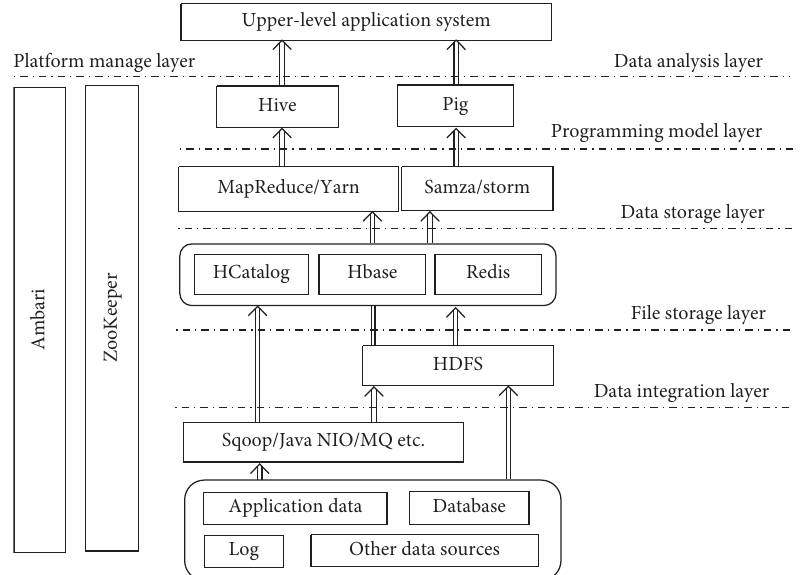
Figure 1: The technical framework of Hadoop.